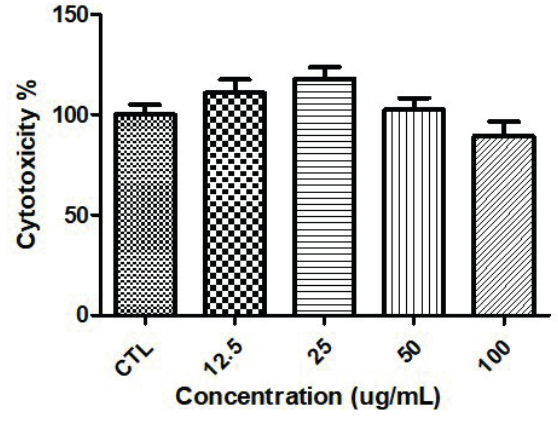
Figure 2 - Evaluation of the cytotoxic effect of the methanol extracts of the leaves of Sambucus australis Cham. & Schltdl (eMSA). evaluation of eMSA cytotoxicity in a splenocyte culture from BAlB/c mice for 72 hours at 37ºC and 5% CO by the MTT-tetrazolium method. *p<0.05 vs . control. ANOVA and Tukey’s